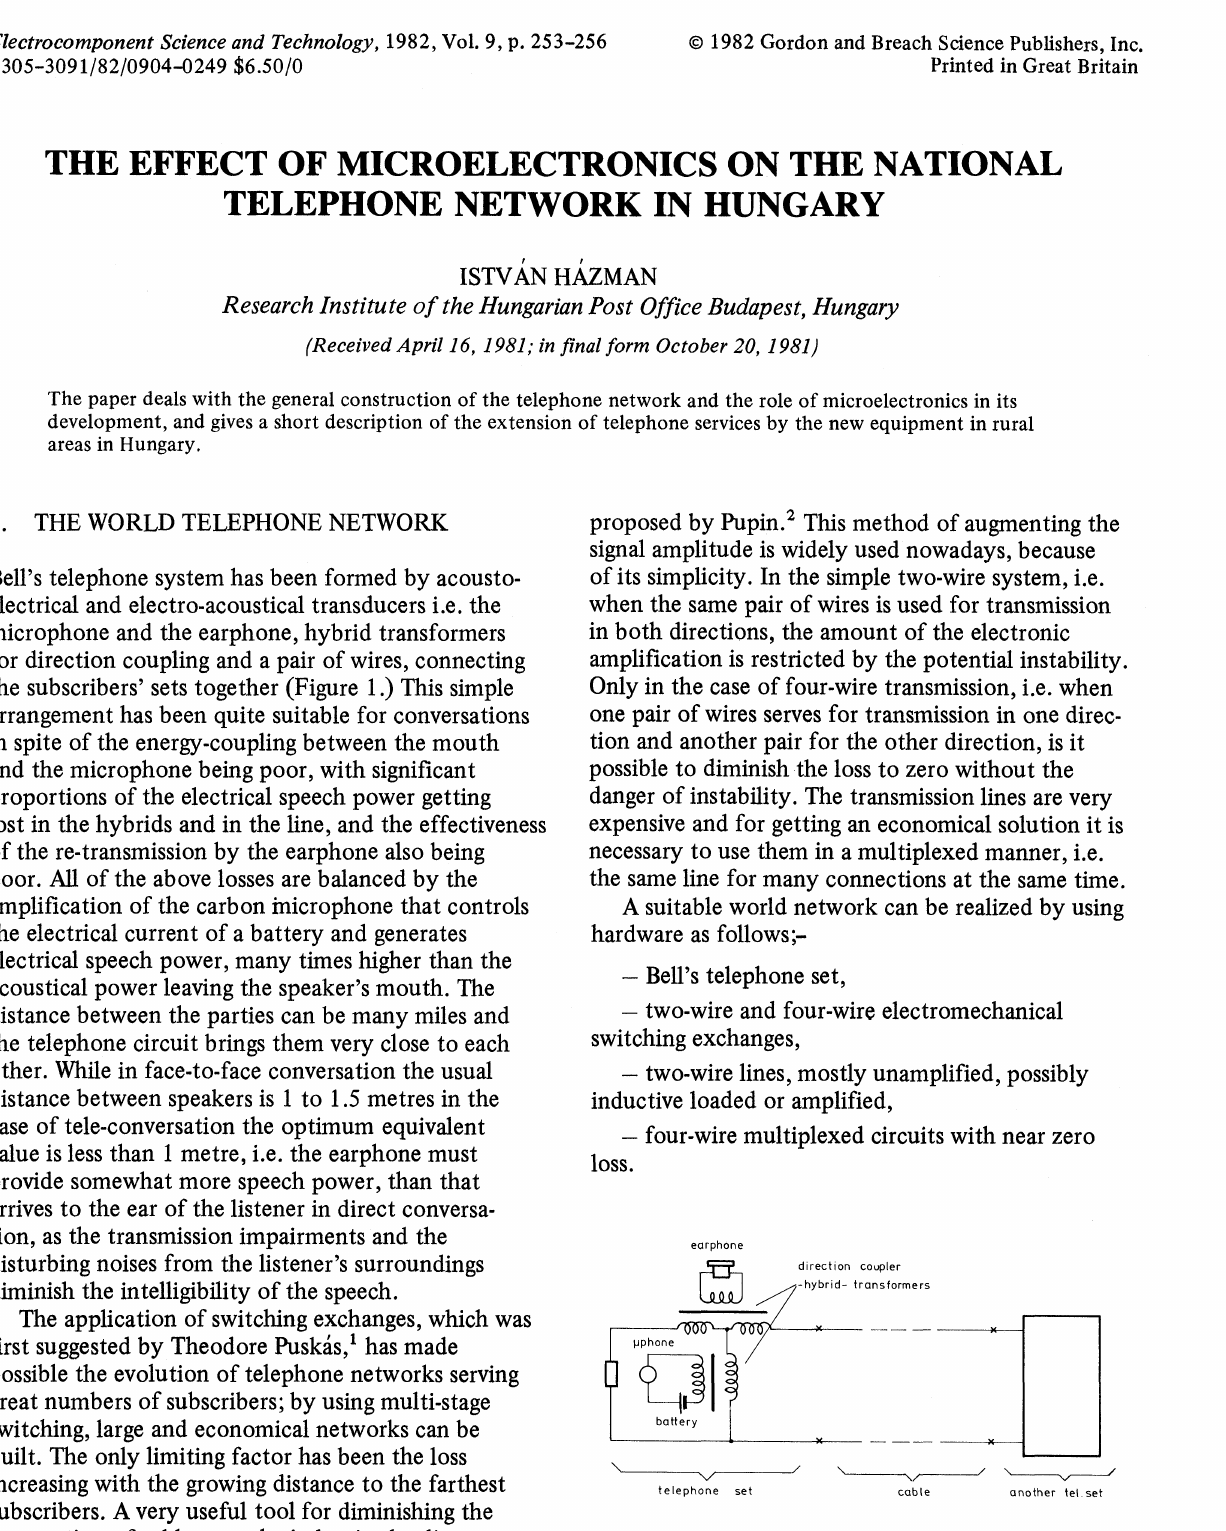
FIGURE Diagram of acouso-electrical telephone